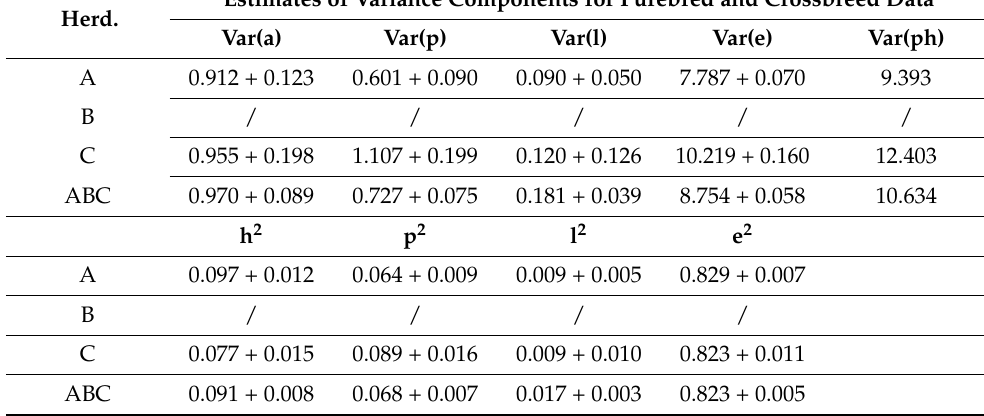
Table 3. Estimates of variance components and ratios with standard errors for NBA using purebred and crossbreed data.